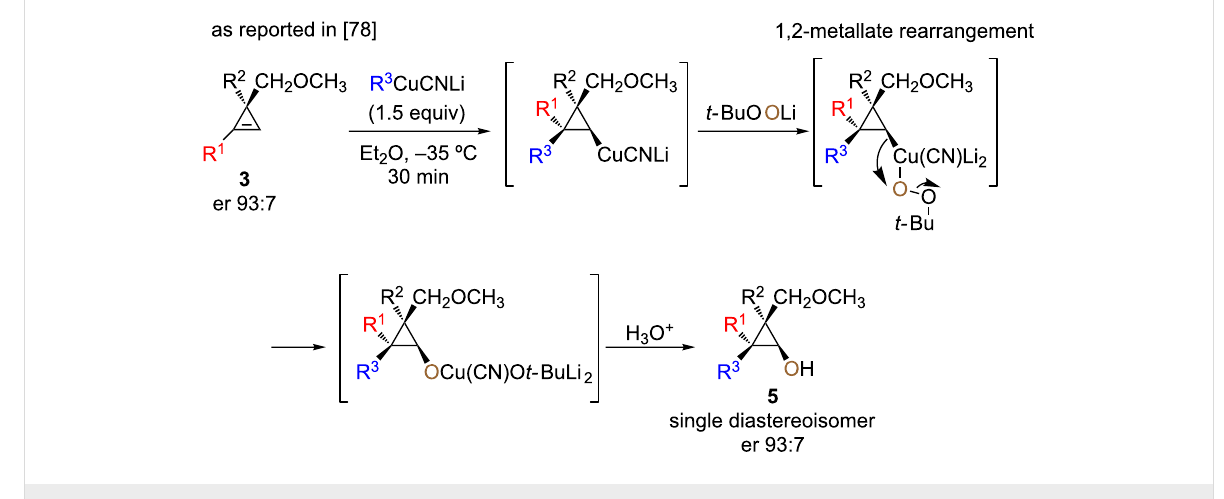
Scheme 5: Diastereoselective formation of